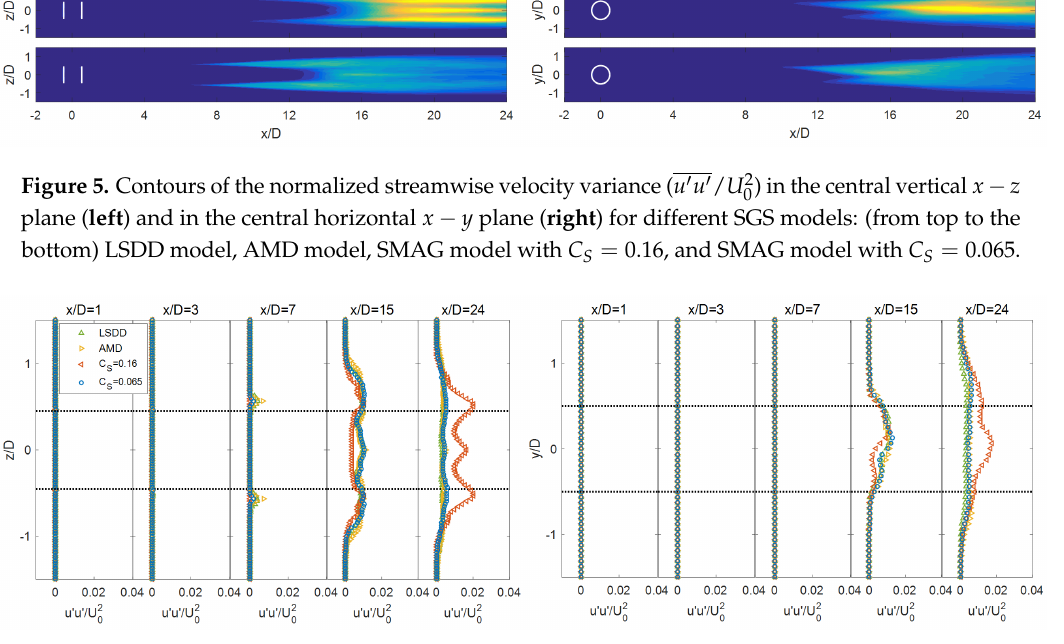
Figure 6. Vertical ( left ) and lateral ( right ) profiles of the normalized streamwise velocity variance ( u (cid:48) u (cid:48) / U 2 ) through the hub level at x / D = 1,3,7,15,24 downwind of the turbine for different 0 SGS